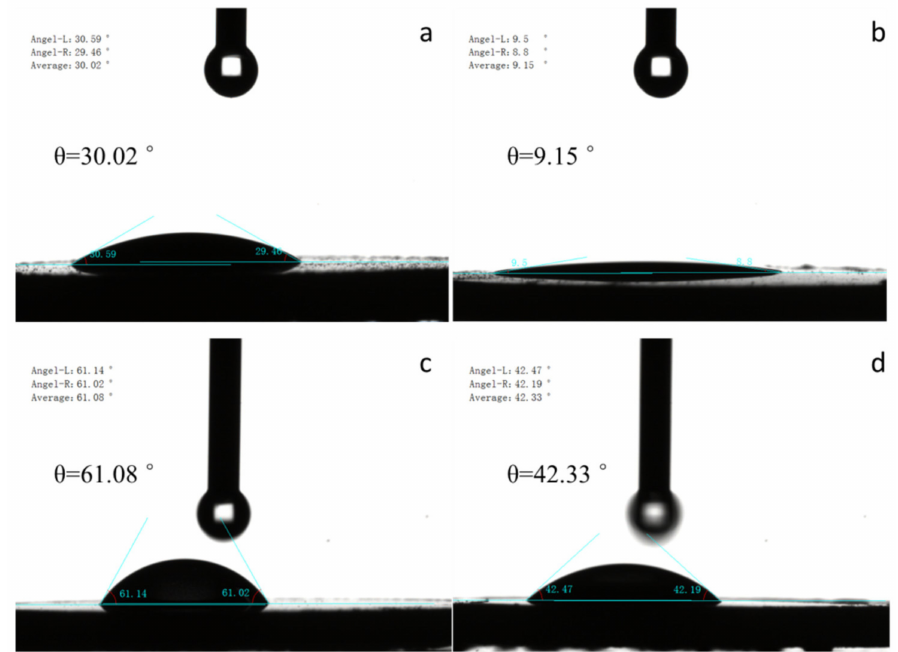
Figure 6. Water contact angle of different fillers: ( a ) GR, ( b ) GA, ( c ) MGR, ( d ) MGA.